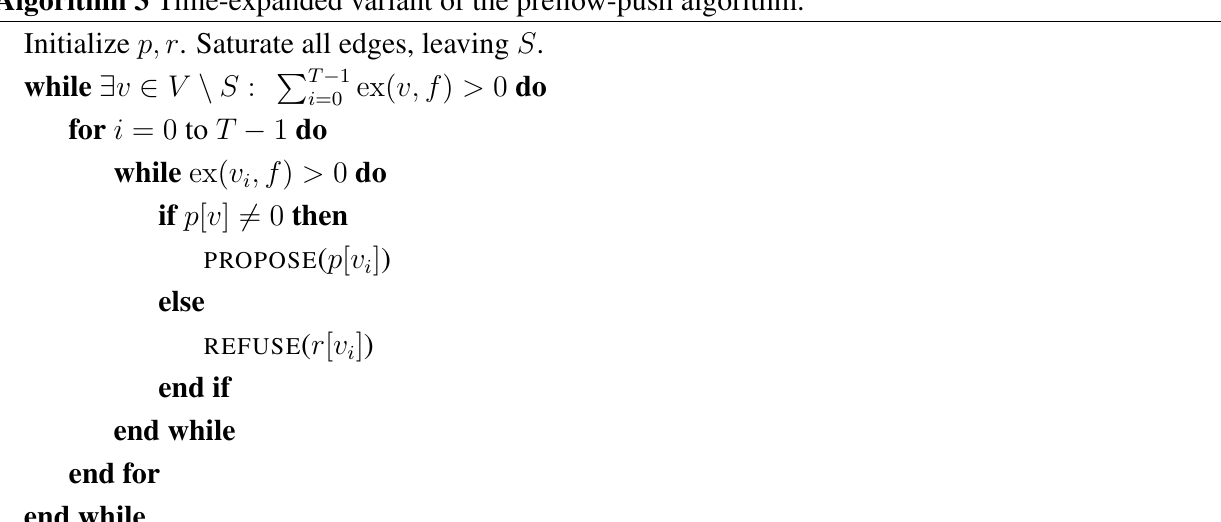
Algorithm 3 Time-expanded variant of the preflow-push algorithm. Initialize p, r . Saturate all edges, leaving S